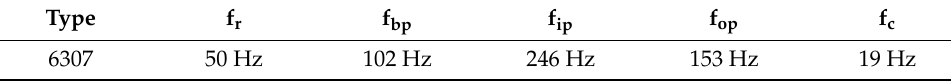
Figure 5. The bearing test-rig and sensors placement illustration. Table 2. Characteristic frequencies of rolling element bearing 6307.